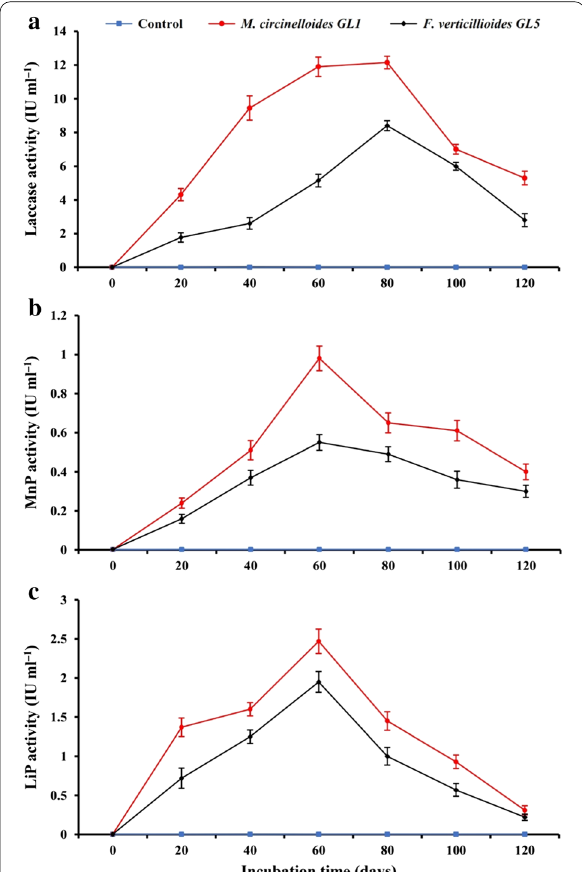
Fig. 2 Changes in ligninolytic enzyme activity of coffee husk treated with ligninolytic fungi during solid-state fermentation in different time intervals. a laccase, b MnP and c